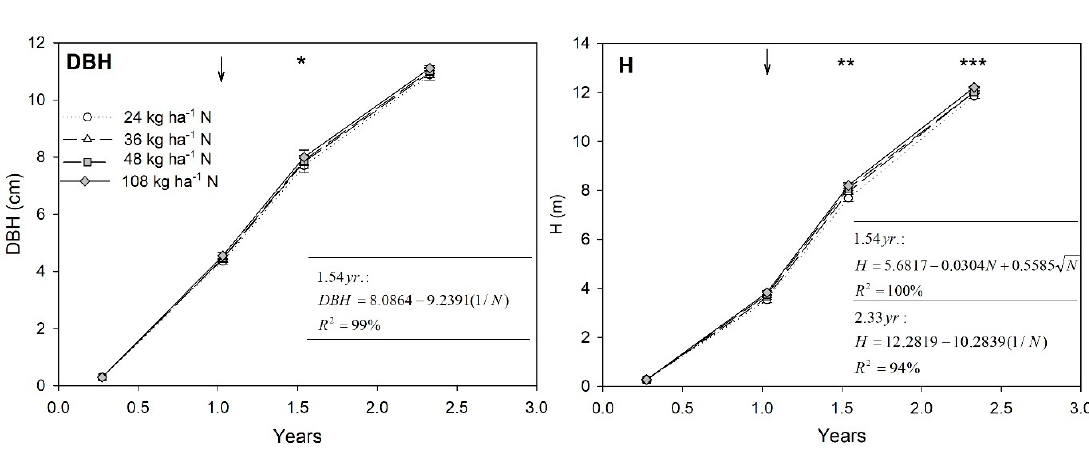
Figure 2. E. dunnii trees’ average diameter at breast height ( DBH , cm) and height ( H , m) as a function of N level at each sampling age. Arrow indicates when treatments were applied. Vertical bars represent standard errors ( n = 4). *, ** and *** indicate significance of regression ( Growth × N ) parameters at each age at 10, 5 and 1%, respectively. Table 2. Effects of N dose on tree variables averaged for all trees at each treatment at 1.08, 1.54 and 2.33-year sampling.